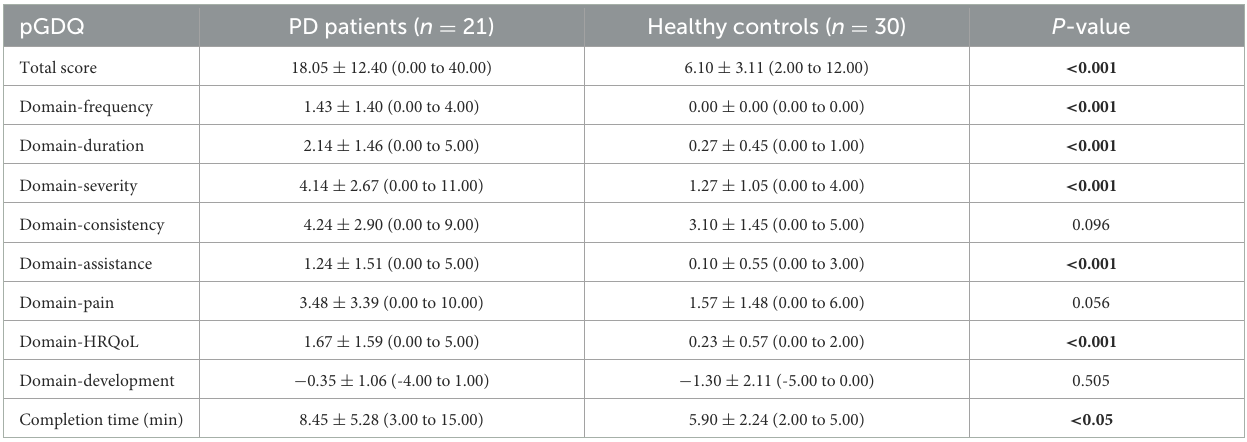
TABLE 2 Total and domain scores and completion time of the preliminary GDQ of patients with Parkinson’s disease and healthy controls of the phase 2a study. pGDQ PD patients ( n = 21) Healthy controls ( n = 30) P